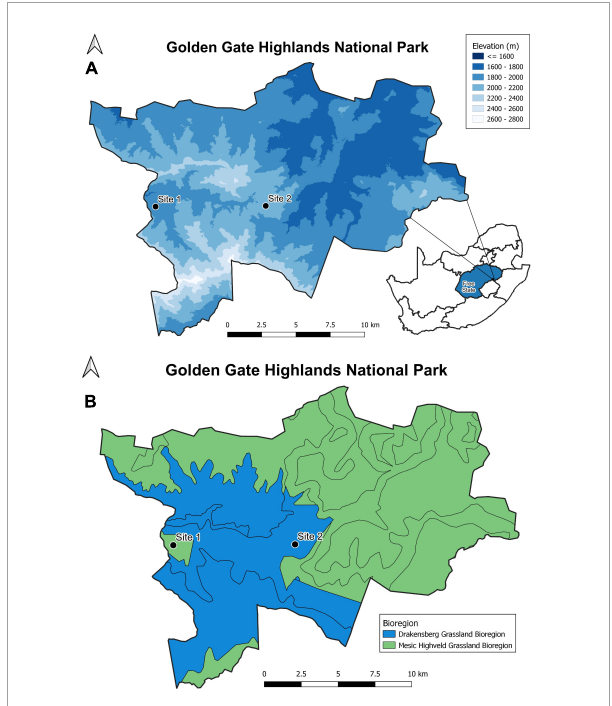
FIGURE1 Map of the GGHNP, Free State Province, South Africa. (A) Elevation map indicating the collection sites used in this study. (B) Map of the Drakensberg and Mesic Highveld Grassland Bioregion types found at the GGHNP. Site 1 is in the Mesic Highveld and site 2 in the Drakensberg Grassland